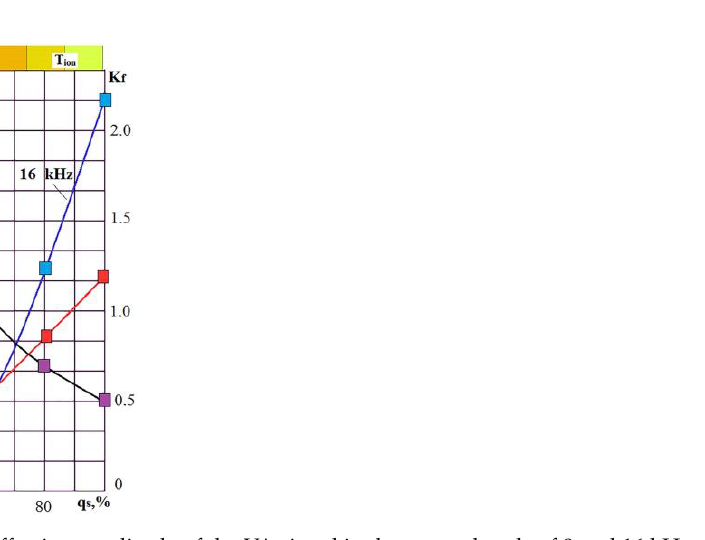
Figure 5. Change in the effective amplitude of the VA signal in the octave bands of 8 and 16 kHz and their K f ratio when the power density q s of laser pulses changes.